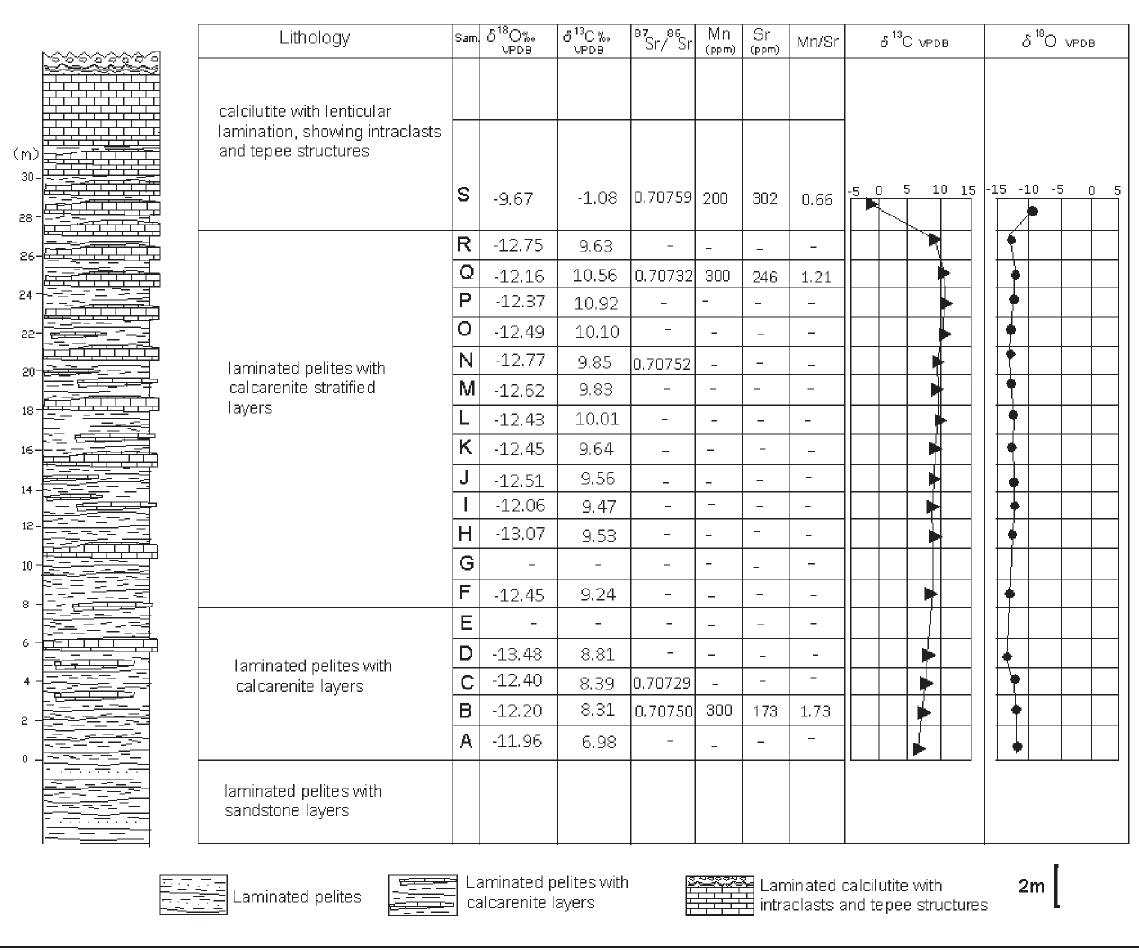
Figure 5 - Lithological variations, elemental and isotopic data of Section 1- Tijucuçu Farm (see Fig. 2 for